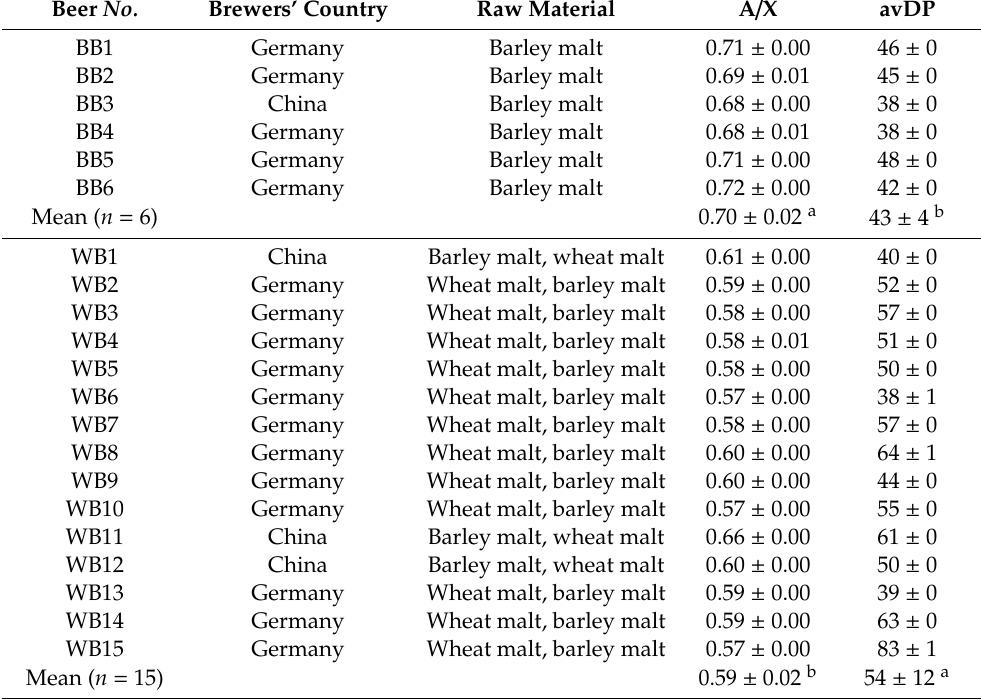
Table 4. The ratio of arabinose to xylose (A / X) and the average degree of polymerization (avDP) of